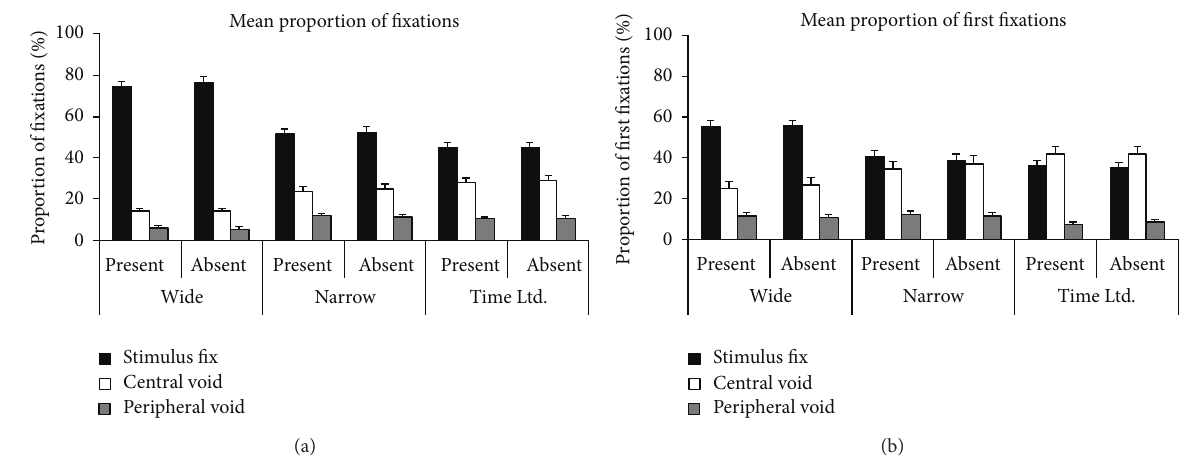
Figure 4: Determinants of CoG fixations and peripheral void fixations. The mean proportion of fixations (a) and mean proportion of first fixations (b) within a trial, depicted separately for the different conditions and different types of fixations (stimulus fixation versus central void fixation versus peripheral void fixation). Error bars depict ± 1 SEM and may not be visible when the SEM is very